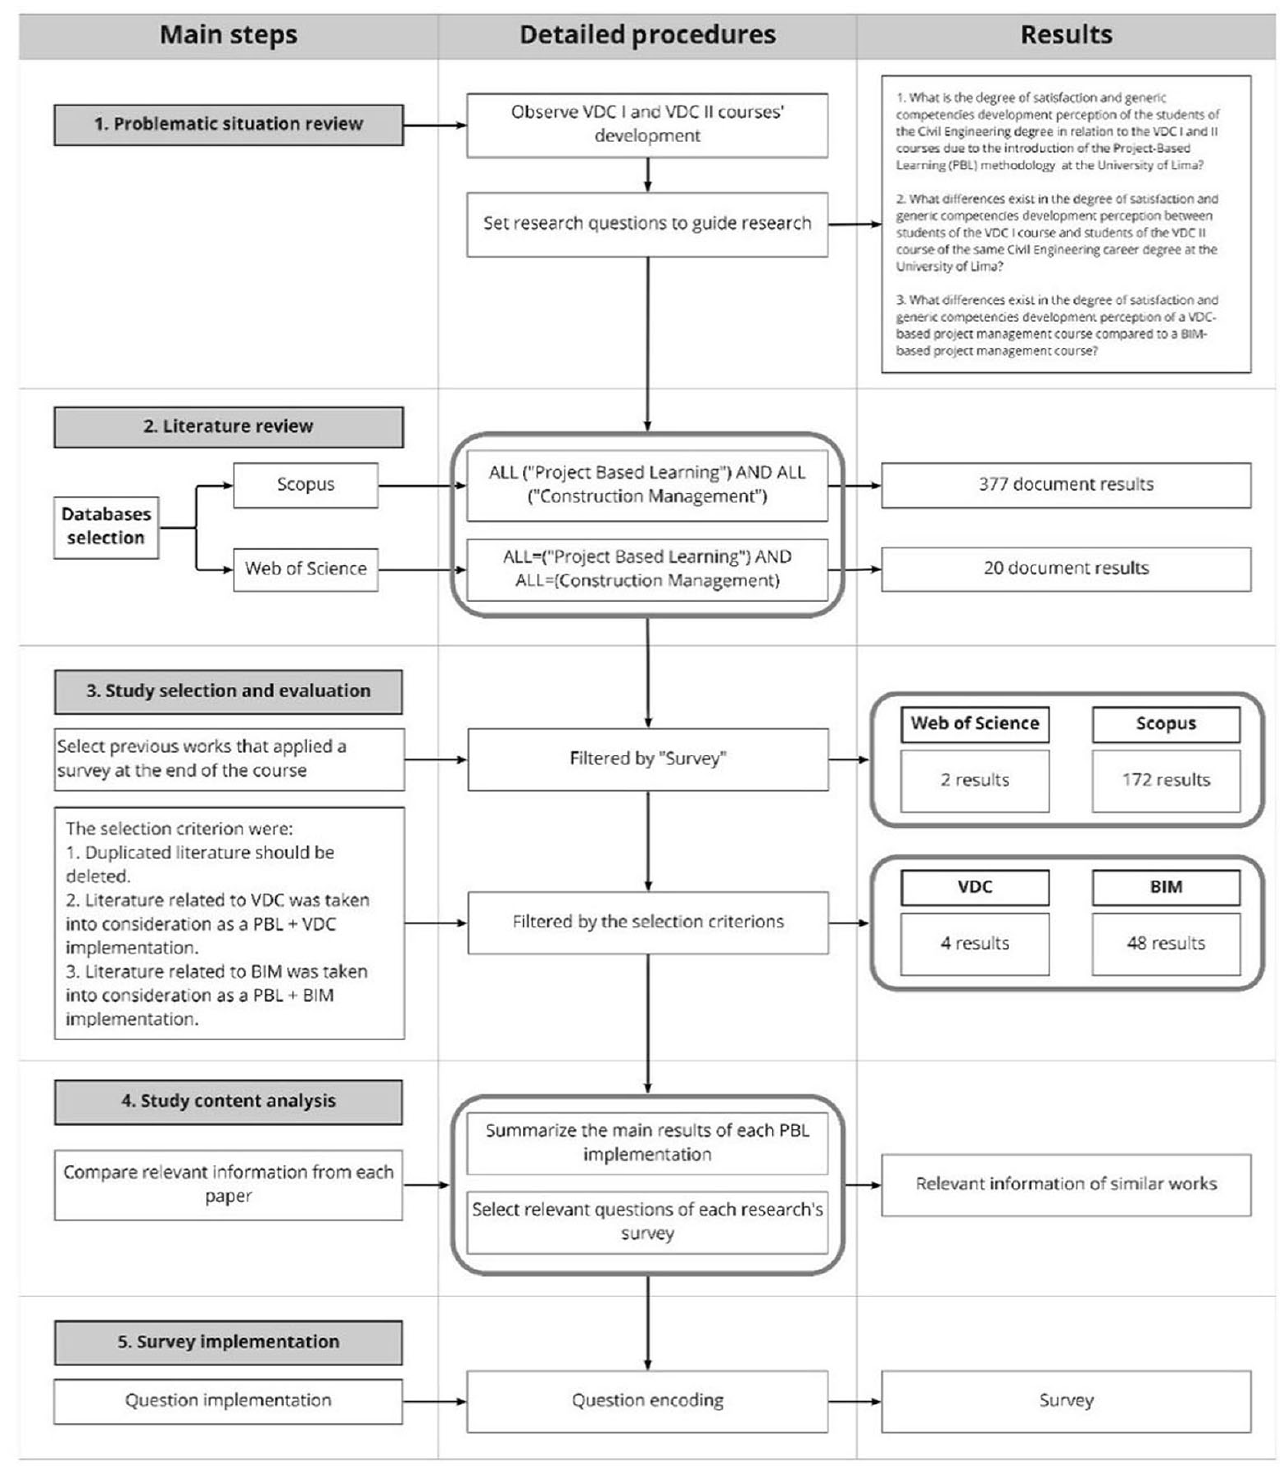
Fig. 3. Research methodology